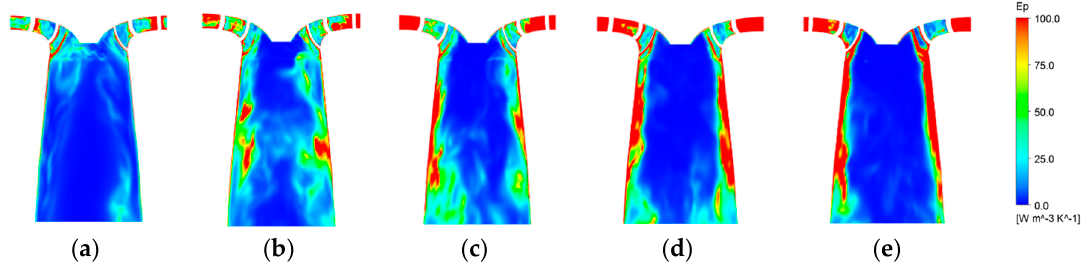
Figure 9. Distribution of the entropy production Ep for 6° GVO at some typical instants; ( a ) t = 0.18 s; ( b ) t = 1.08 s; ( c ) t = 2.52 s; ( d ) t = 3.18 s; ( e ) t = 3.48 s.